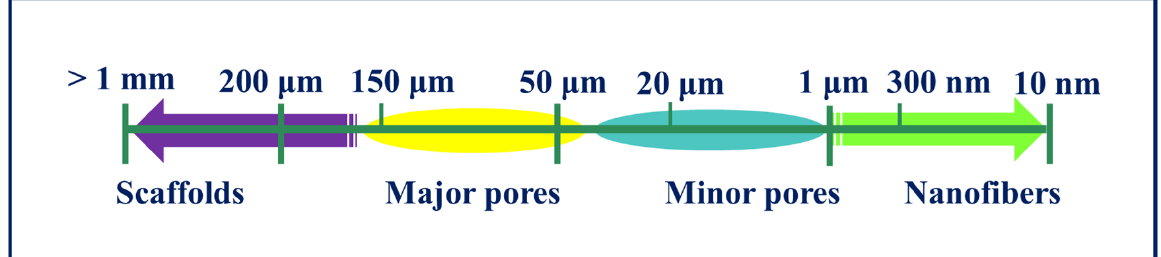
Figure 5. Scheme of different size scales of relevant structures. Table 5. The porosity and pore size of polymer scaffolds.